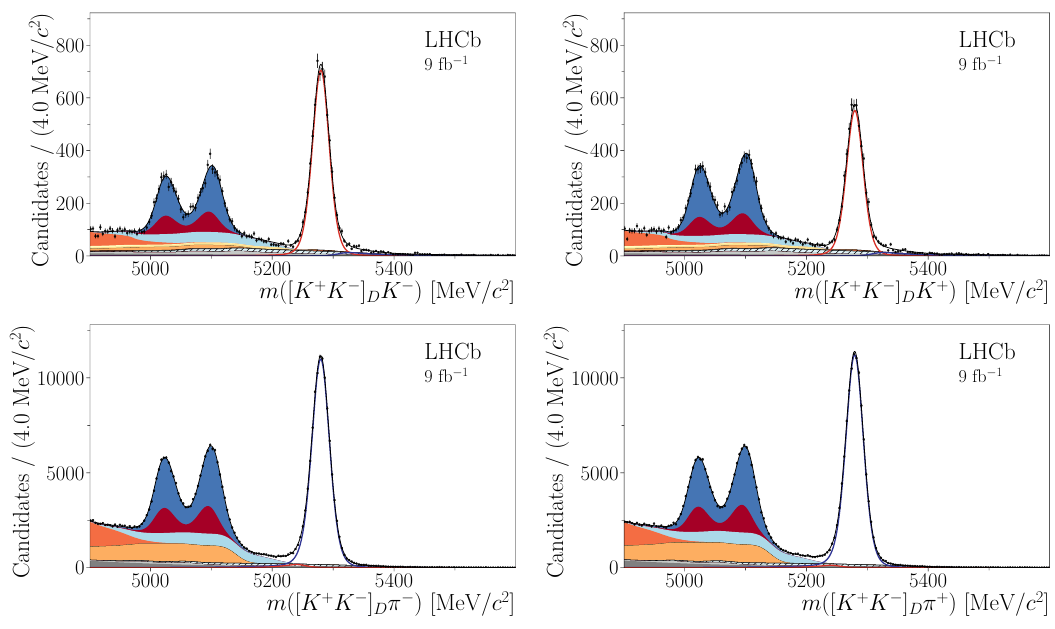
Figure 4 . Invariant-mass distribution of B ± → [ K + K − ] D h ± candidates with the fit result overlaid. A legend is provided in figure 1.